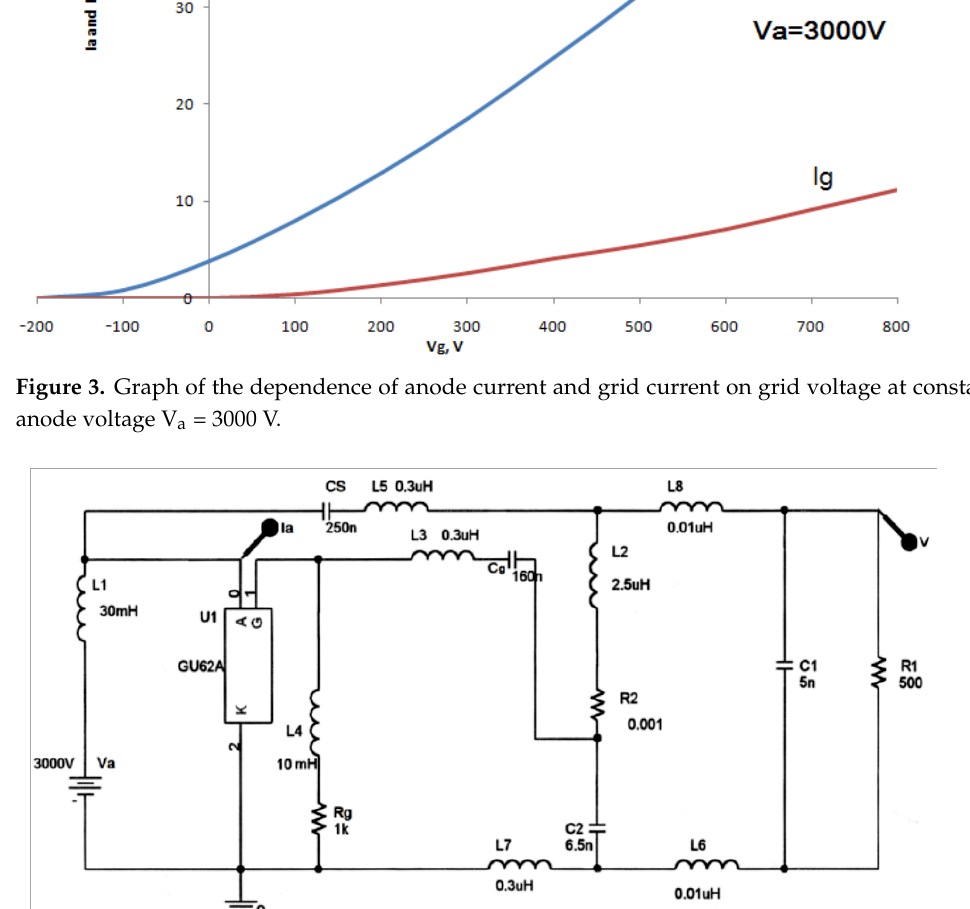
Figure 4. Complete circuit diagram for simulation of the designed generator.